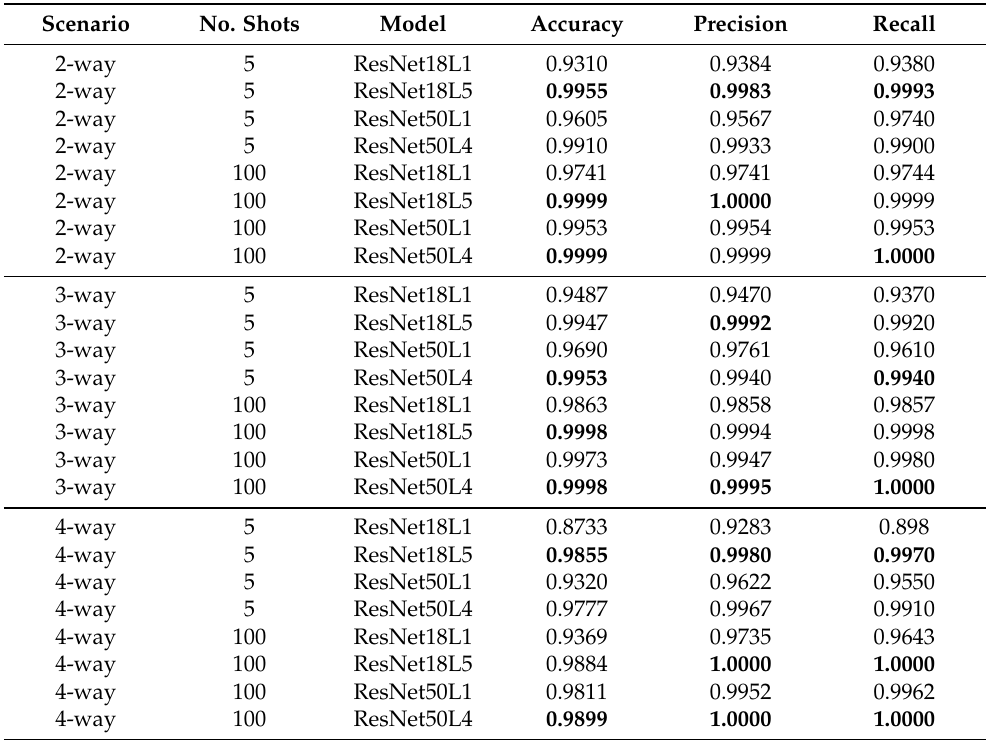
Table 1. Summary of classification results for 5-shot and 100-shot